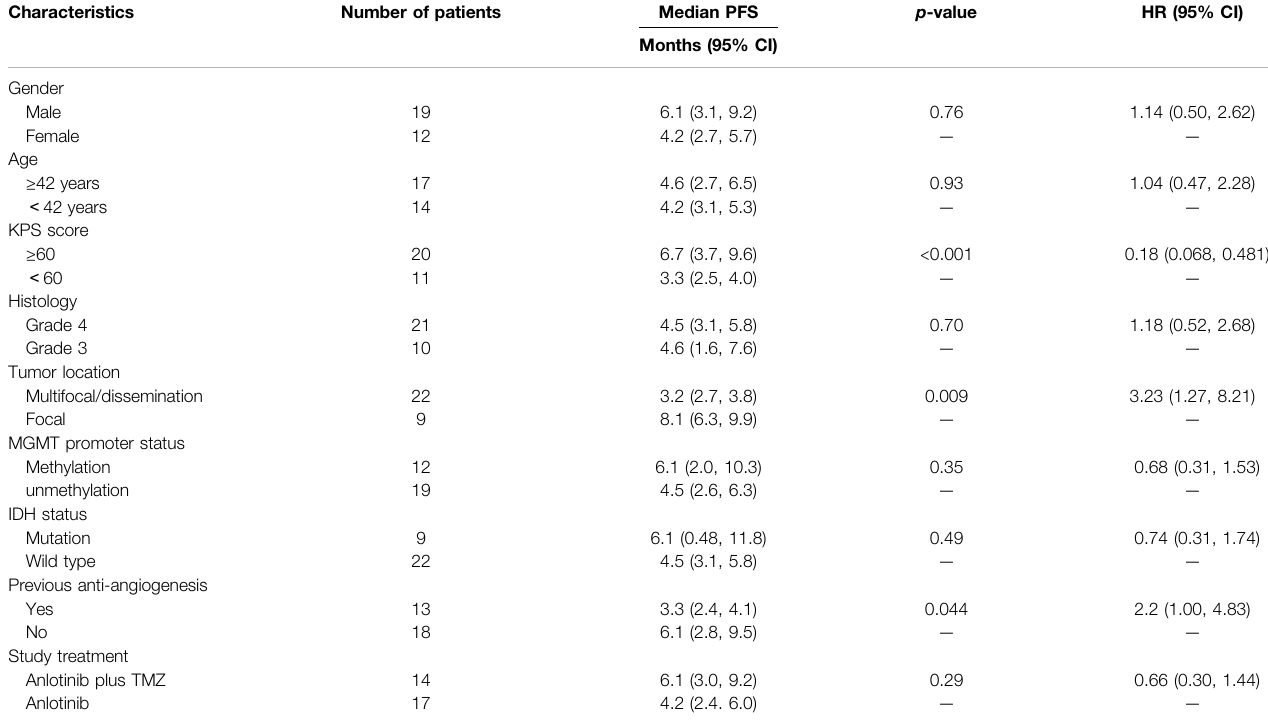
TABLE 2 | Results of the univariate analysis. Characteristics Number of